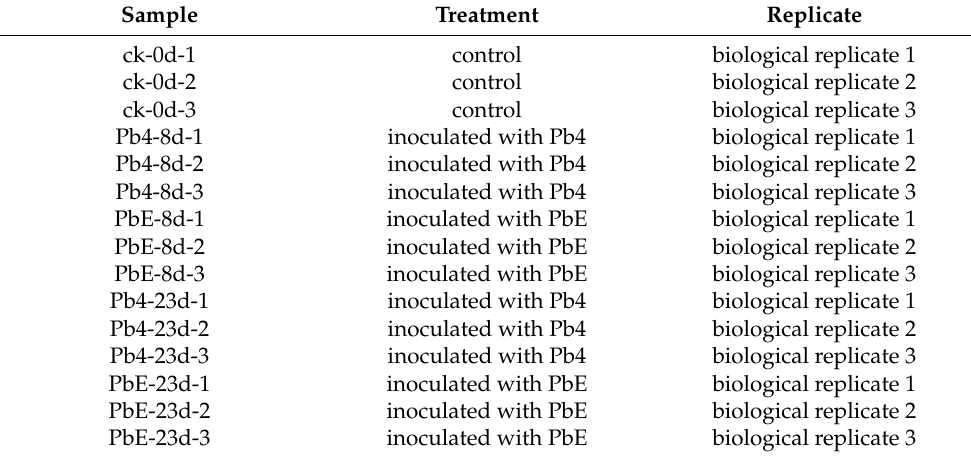
Table 1. Profile of sample